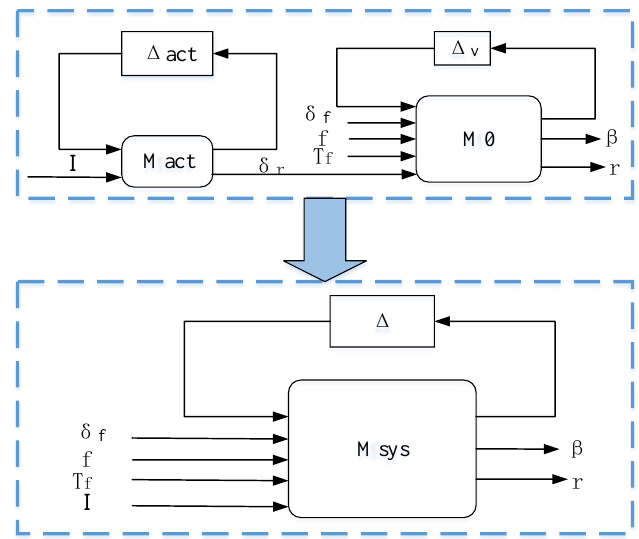
Figure 9. Linear fractional transformation (LFT) representation of 4WS vehicle stability control system with dynamic perturbations.